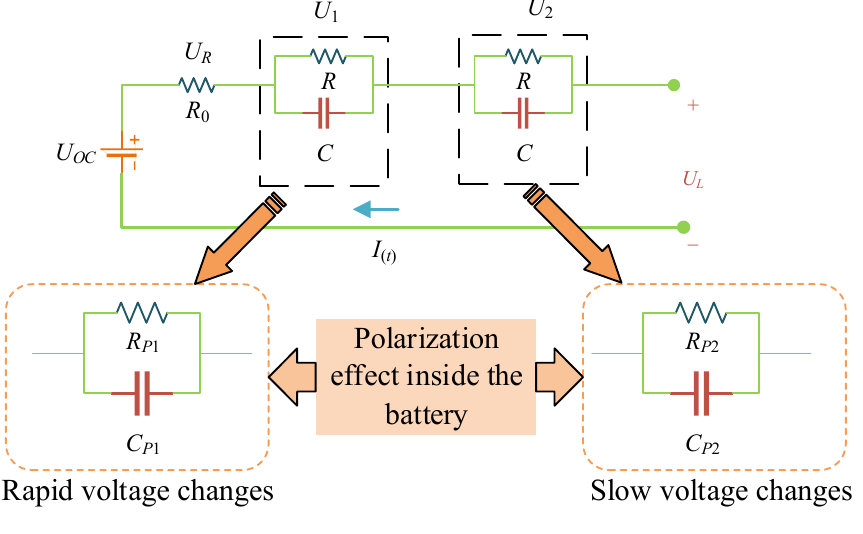
Figure 1. The SO-PEC model.